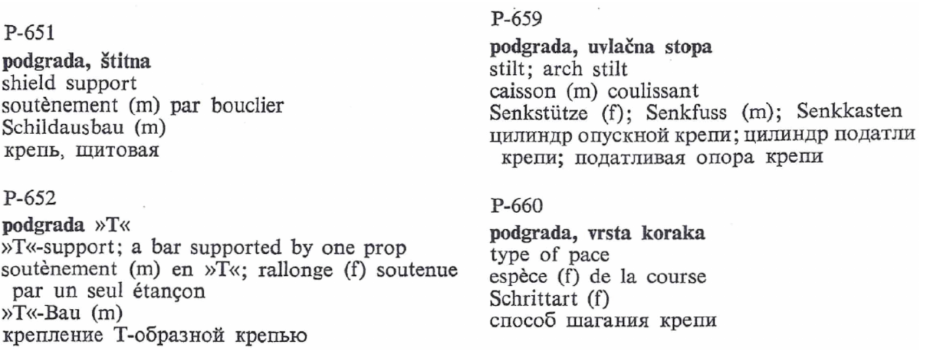
Figure 1. Examples of scanned Mining dictionary